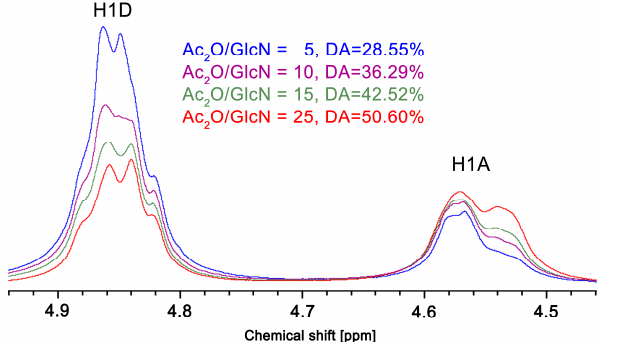
Figure 6. 1 H-NMR spectra of acetylated chitosans with different Ac 2 O/GlcN molar ratios (DCl/D 2 O, 70 °C, 500 MHz).